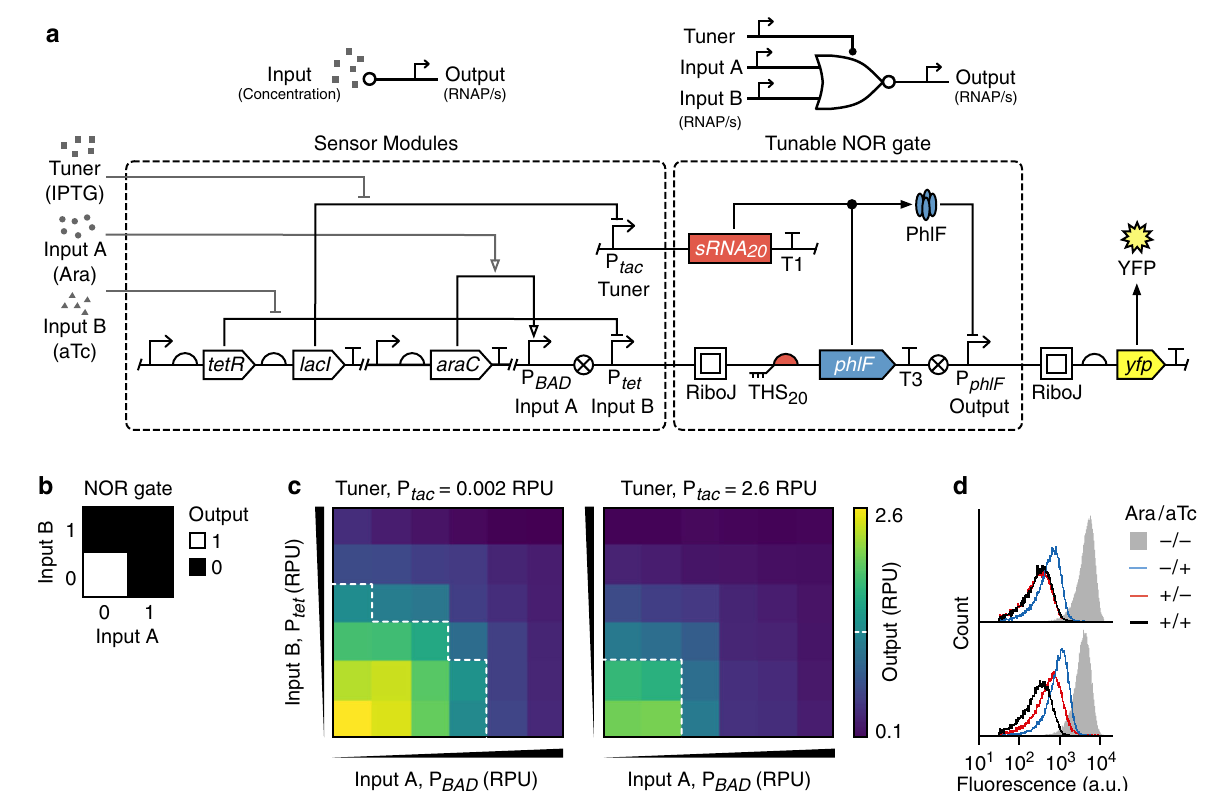
Fig. 5 Design and characterization of a tunable NOR gate. a Schematic of all the sensor systems used (top, left), the tunable NOR gate (top, right), and their genetic implementation (bottom, dashed boxes). Yellow fl uorescent protein (YFP) expression is driven by the output promoter and T1 and T3 correspond to the transcriptional terminators L3S3P11 and ECK120033737, respectively 65 . b Function of a two-input NOR gate. c Heatmaps showing the output of the tunable NOR gate for varying input promoter activities (Input A – P BAD : 0.008, 0.003, 0.15, 0.5, 2.5, 3.1 RPU; Input B – P tet : 0.05, 0.5, 1.6, 3.1, 6.4, 7.5 RPU) and for low (left) and high (right) tuner promoter activities. Output promoter activities shown are average values calculated from fl ow cytometry data for three biological replicates. White dashed line shows an output of 1.2 RPU and denotes the transition point from a high to low output. d Flow cytometry distributions of the output YFP fl uorescence for tuner promoter activities of 0.002 RPU (bottom) and 2.6 RPU (top). The four distributions correspond to combinations of the absence and presence of L -Arabinose (10 mM) and aTc (50 ng/mL). Source data are available in the Source Data fi